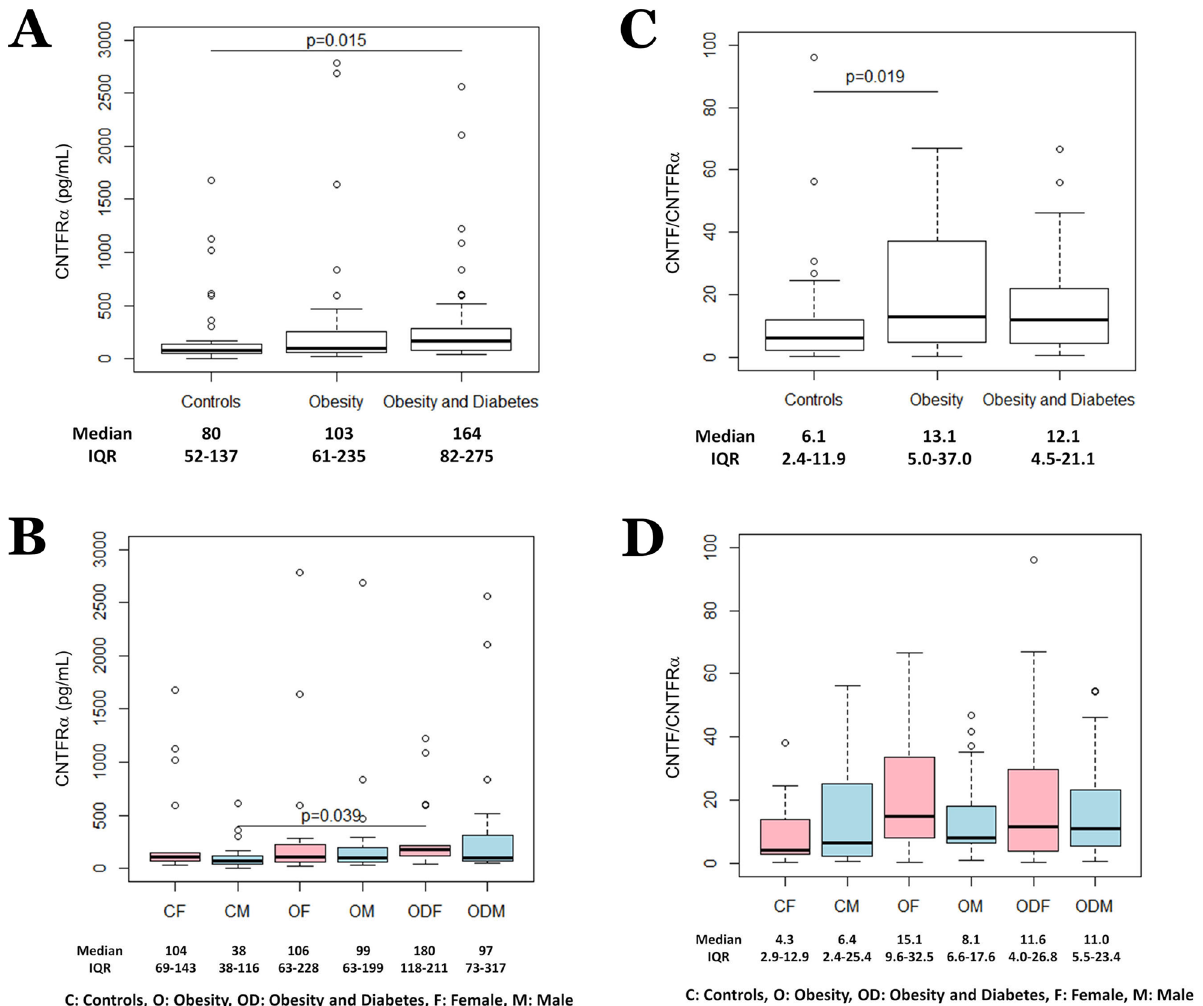
Figure 4. Plasma CNTFRα level distribution according to health condition ( A ) and health condition and gender ( B ). CNTF/CNTFRα molar ratio distribution according to health condition ( C ) and health condition and gender ( D